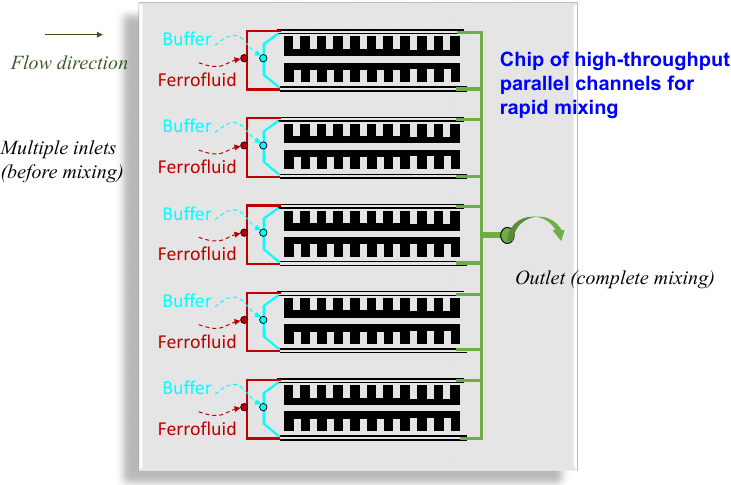
Figure 9. High-throughput microfluidic chip with integrated parallel channels for rapid